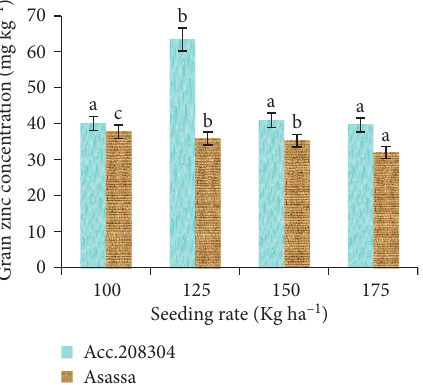
Figure 5: Grain Zn concentration (mg kg − 1 ) due to wheat variety by seeding rate interaction effects. Bars designated with different letters are statistically